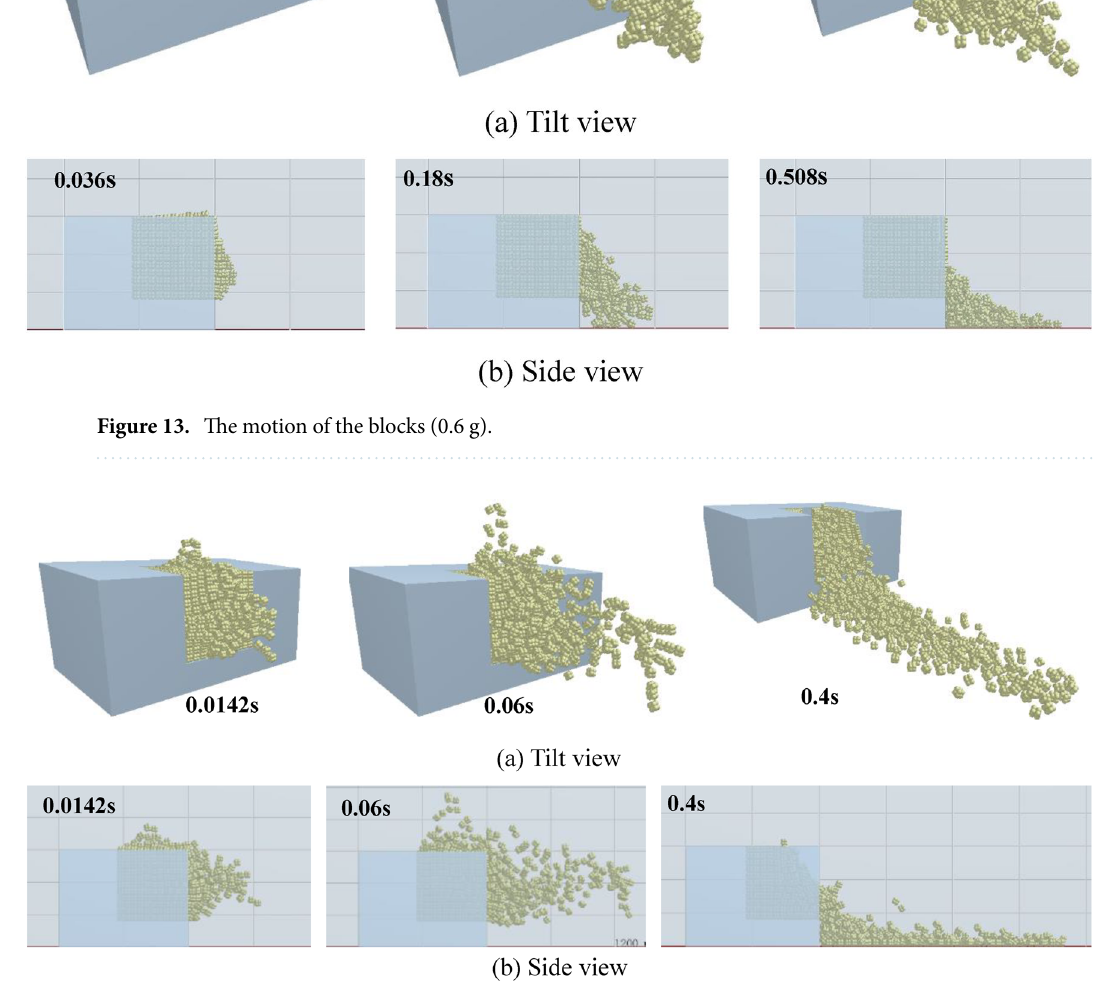
Figure 14. The motion of the blocks (0.8